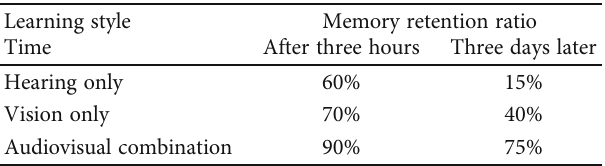
Figure 6: Understandability output and second language acceptance logic. Table 1: Memory retention rate of sensory